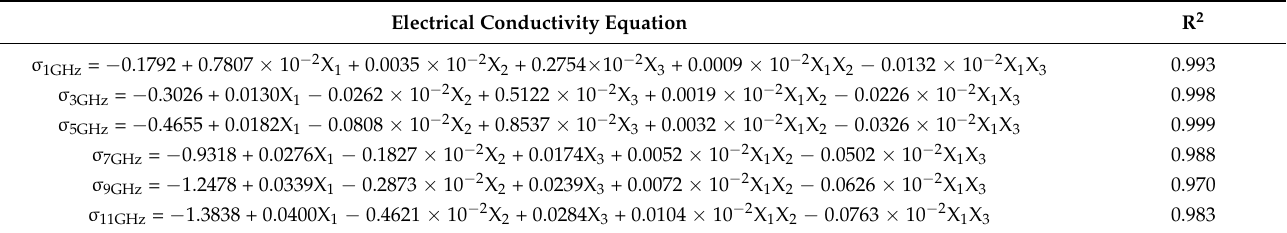
Table 4. Regression equations for the electrical conductivity ( σ ) of the porous nHA/S composites at 1, 3, 5, 7, 9, and 11